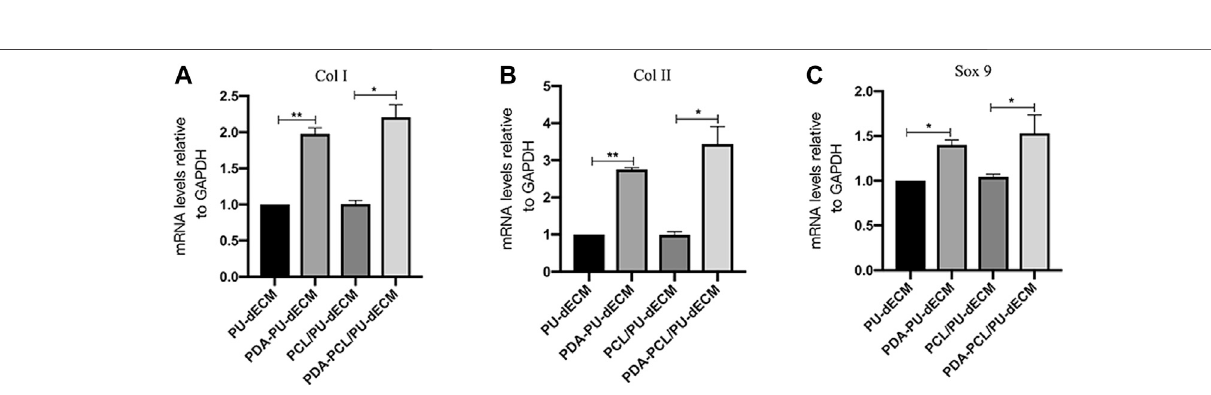
Frontiers in Materials |